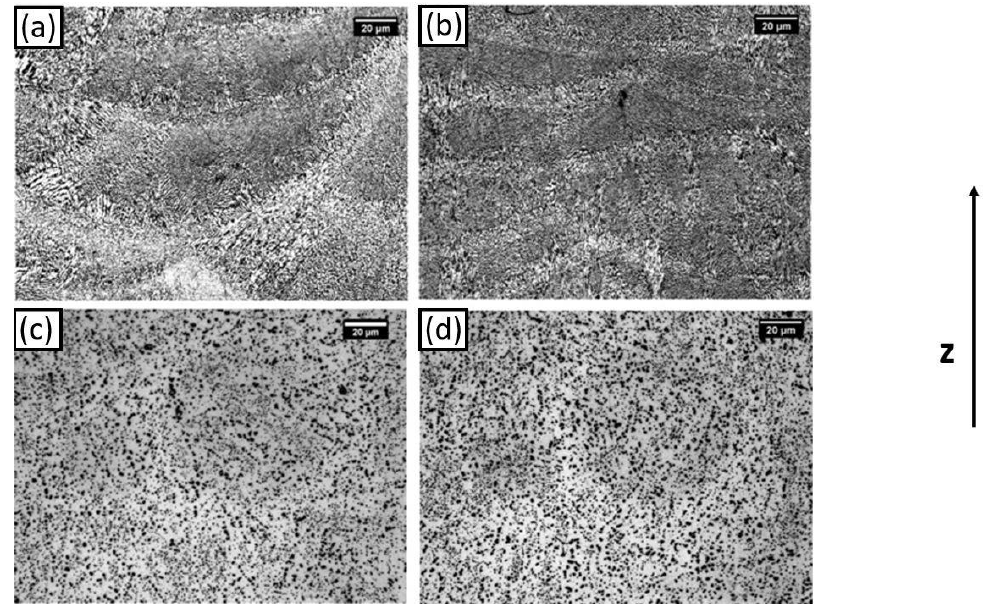
Figure 6. Optical micrographs at 500 × of ( a ) AB, ( b ) DA-6, ( c ) S-SHT, and ( d ) S-T6-6 F357 samples.